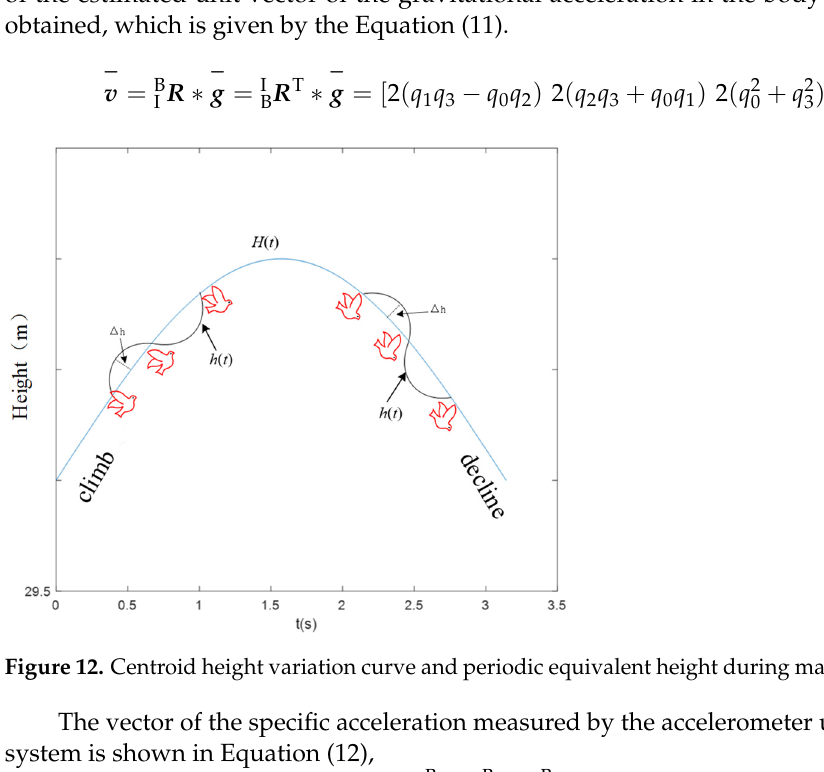
Figure 11. Variation curve of centroid height and periodic equivalent height during cruise flight.